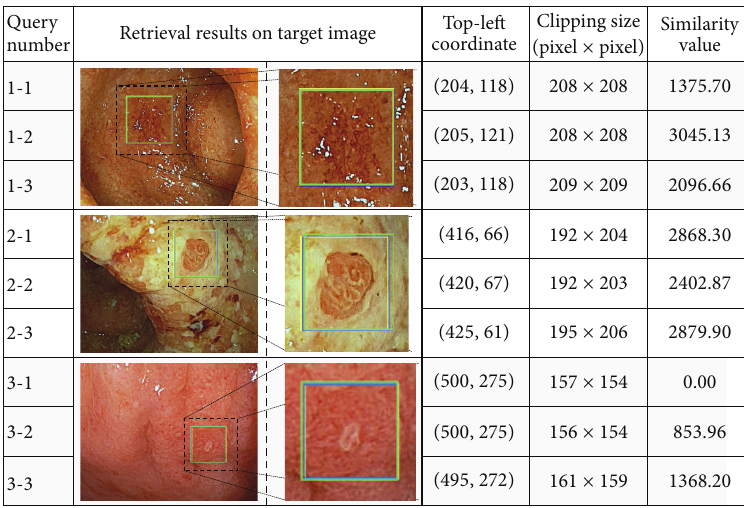
Figure 12: Retrieval results for query quasi-objects.